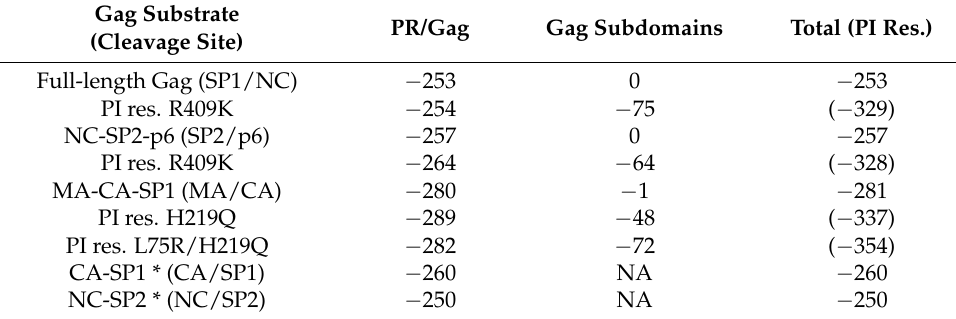
Table 1. Interaction energy scores (IESs) in kcal/mol between PR and Gag substrates, and Gag substrate subdomains. Column 1 lists Gag substrates with cleavage site, and Gag non-cleavage site PI resistance mutation(s) indicated (PI res.); Column 2, IES between HIV-1 PR and indicated Gag substrate (PR/Gag); Column 3, IES between Gag substrate subdomains (Gag subdomains); Column 4, total IES (Column 2 plus Column 3 values) for the same Gag substrate, with Gag substrates with non-cleavage site PI resistance mutations (PI res.) IES in brackets. * The CA-SP1 and NC-SP2 Gag substrates do not have a subdomain on both sides of the cleavage site so no IES was reported in Column 3, not applicable